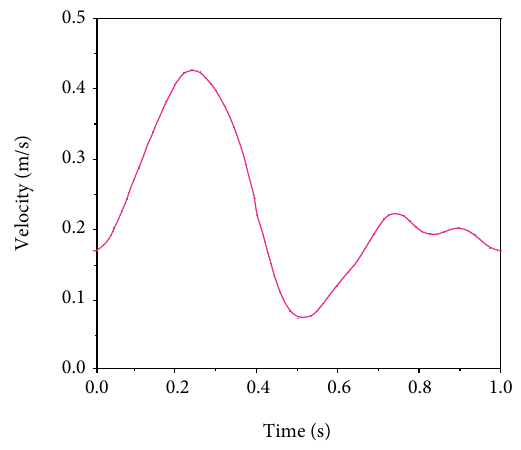
Figure 2: Mean incoming velocity pro fi le.